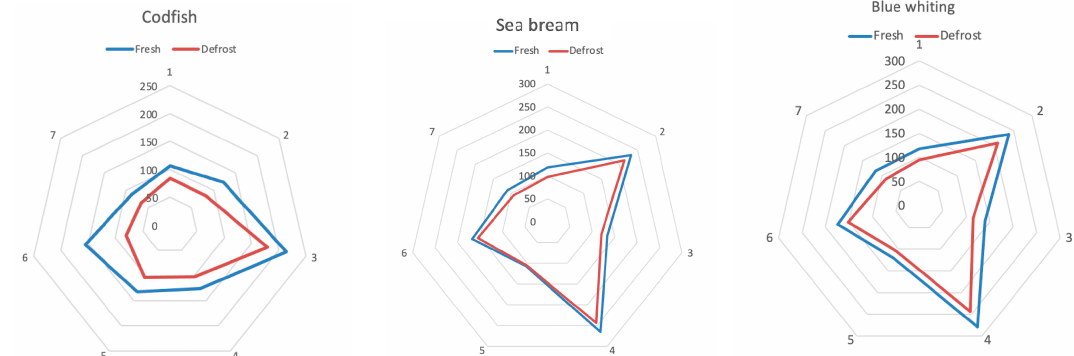
Figure 6. Fingerprints registered by the seven sensors of the BIONOTE-V; from left to right: codfish, sea bream, blue whiting. For each species two fingerprints are reported: (blue) fresh sample, (red) defrosted sample. Each of the 7 axes is relative to the response given by each of the QBM sensors. The response is in Hz, because it is a frequency shift with respect to the resonance frequency.